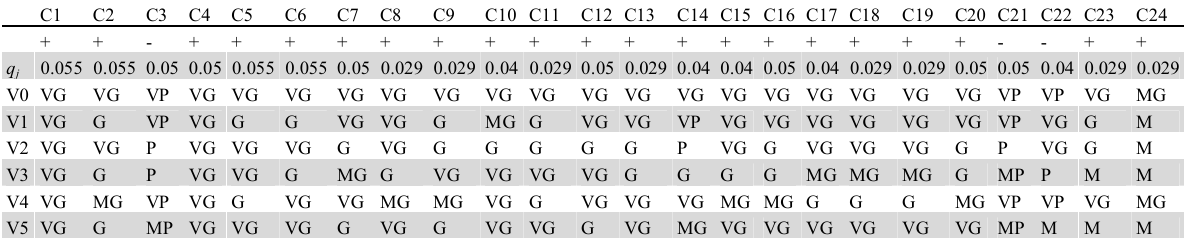
Linguistic Decision-making Matrix